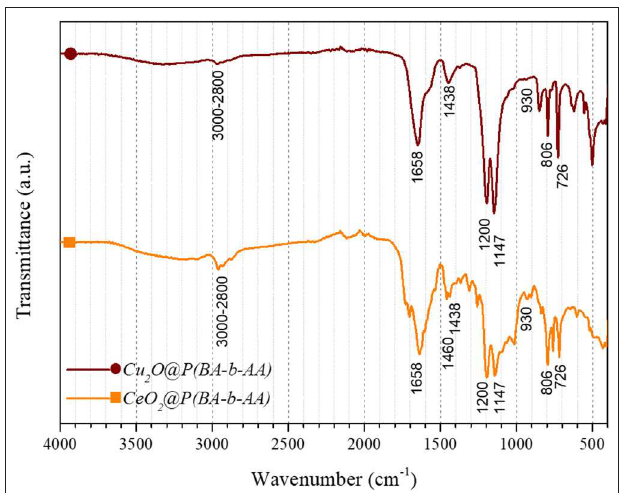
FIGURE 4 | FT-IR diagrams of the CeO 2 @P(BA-b-AA) and Cu 2 O@P(BA-b-AA) core-shell microcapsules.